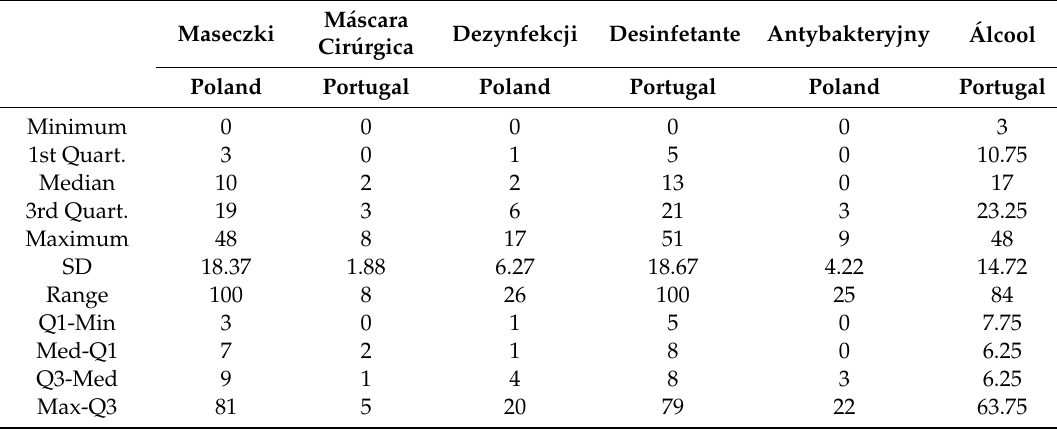
Table 1. Descriptive numerical analysis of the